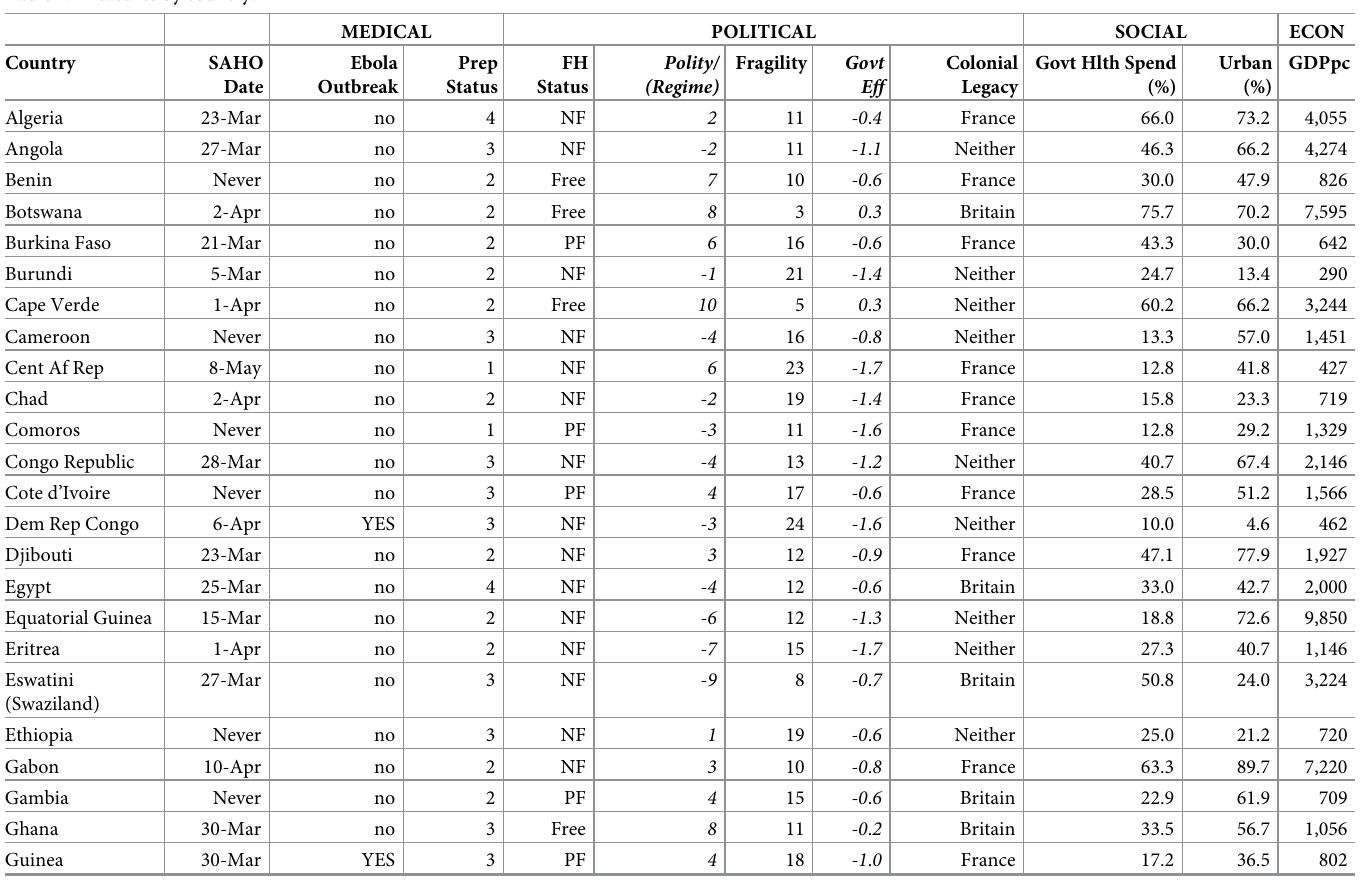
Table 2. Measures by